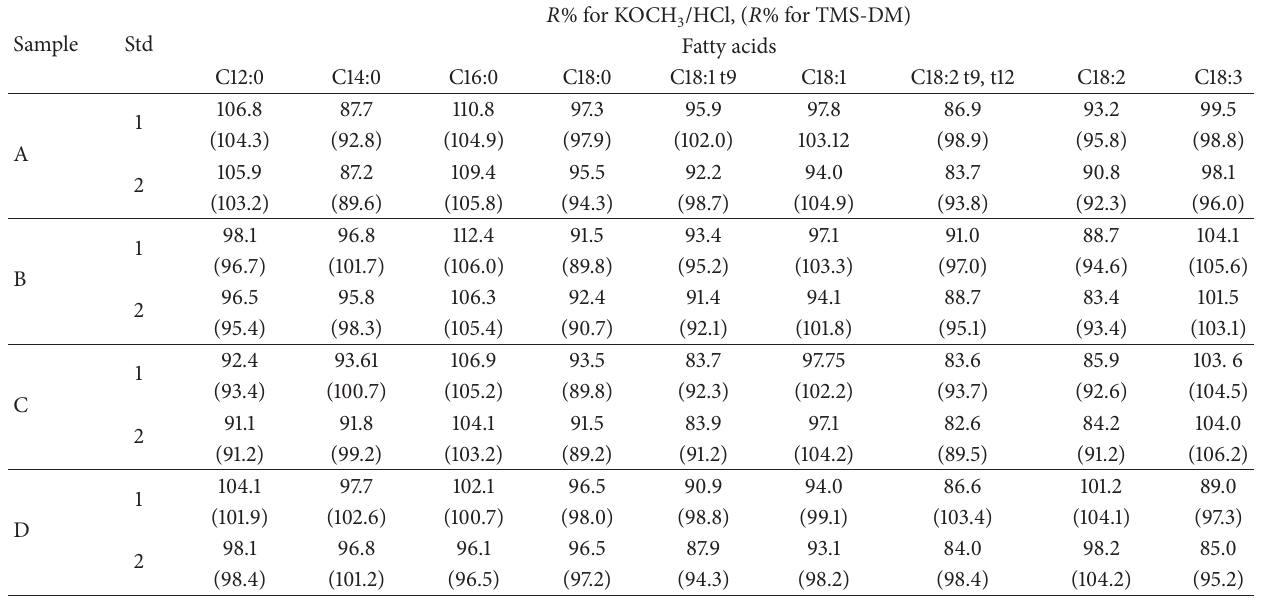
Table 4: The recovery percentage ( 𝑅 %, calculated from four samples studied) at two addition levels for both methods employed. Sample